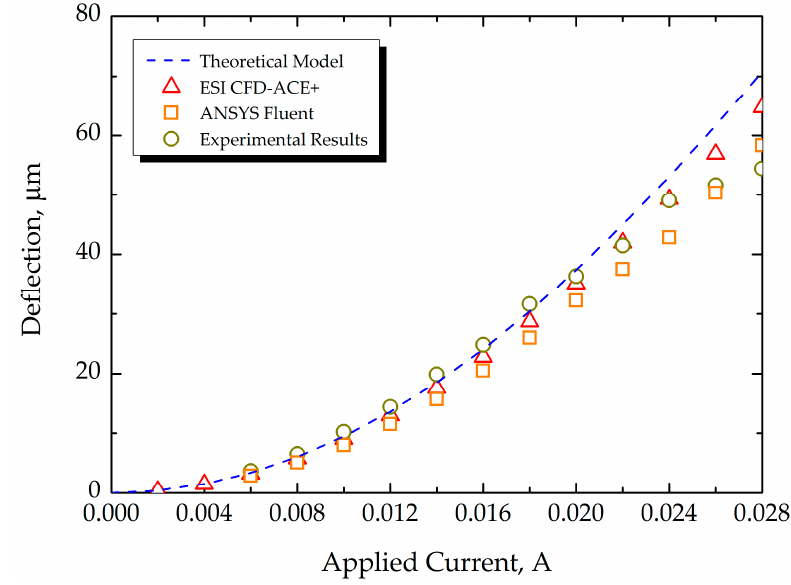
Figure 12. Comparison of deflection among FEA models (ANSYS and ESI CFD-ACE+), theoretical model, and experimental data.